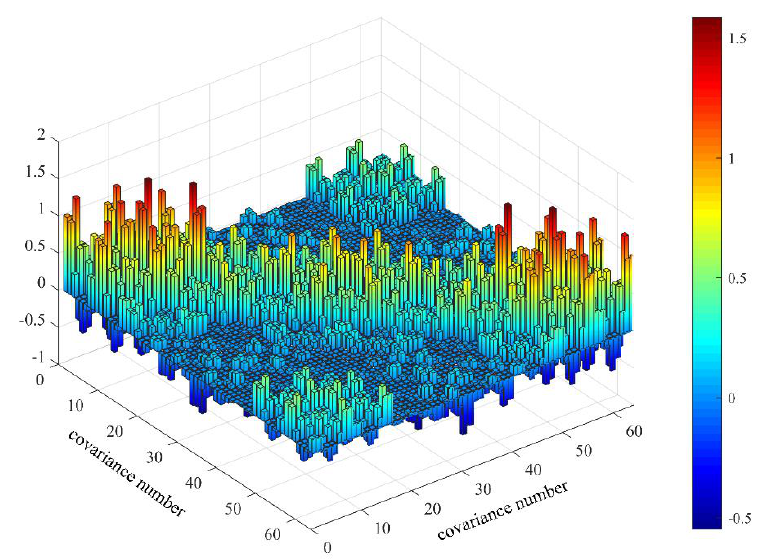
Figure 10. The covariance matrix Θ of the reflection plate of the subarray ( F = 3 mm).